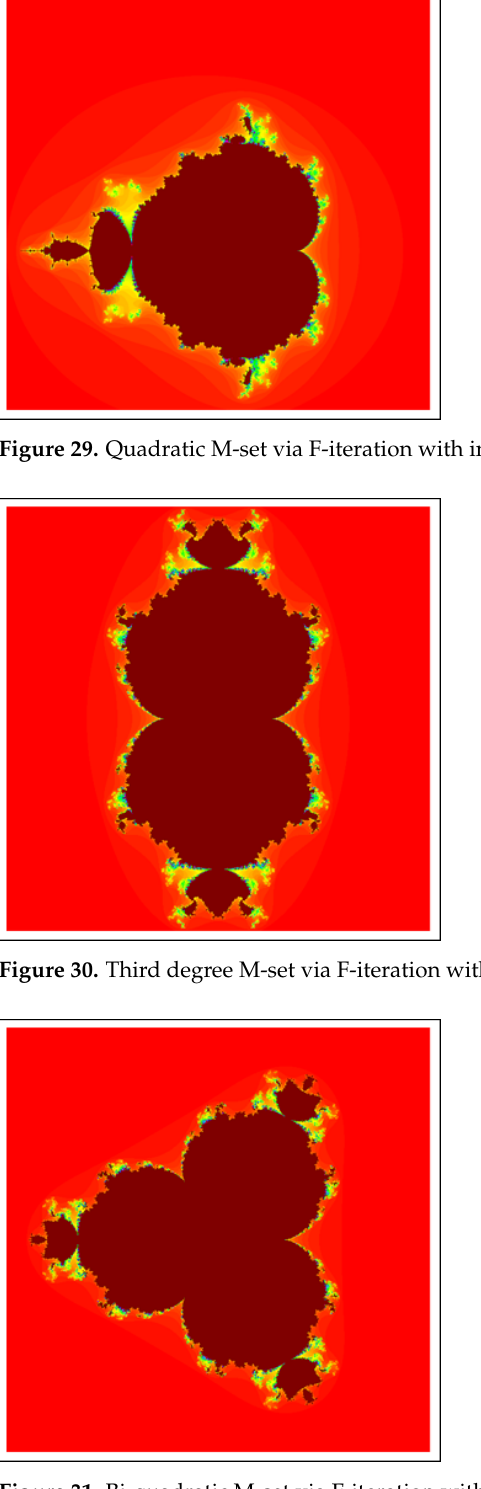
Figure 31. Bi-quadratic M-set via F-iteration with visual time = 139.7